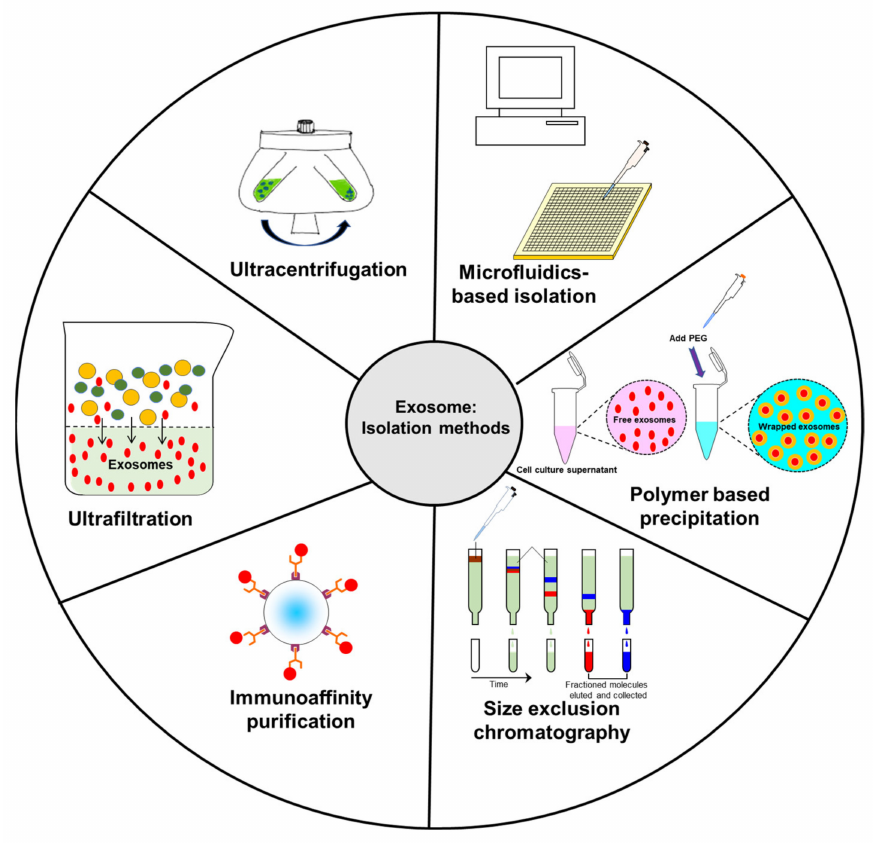
Figure 2. Schematic diagram representing common isolation methods for